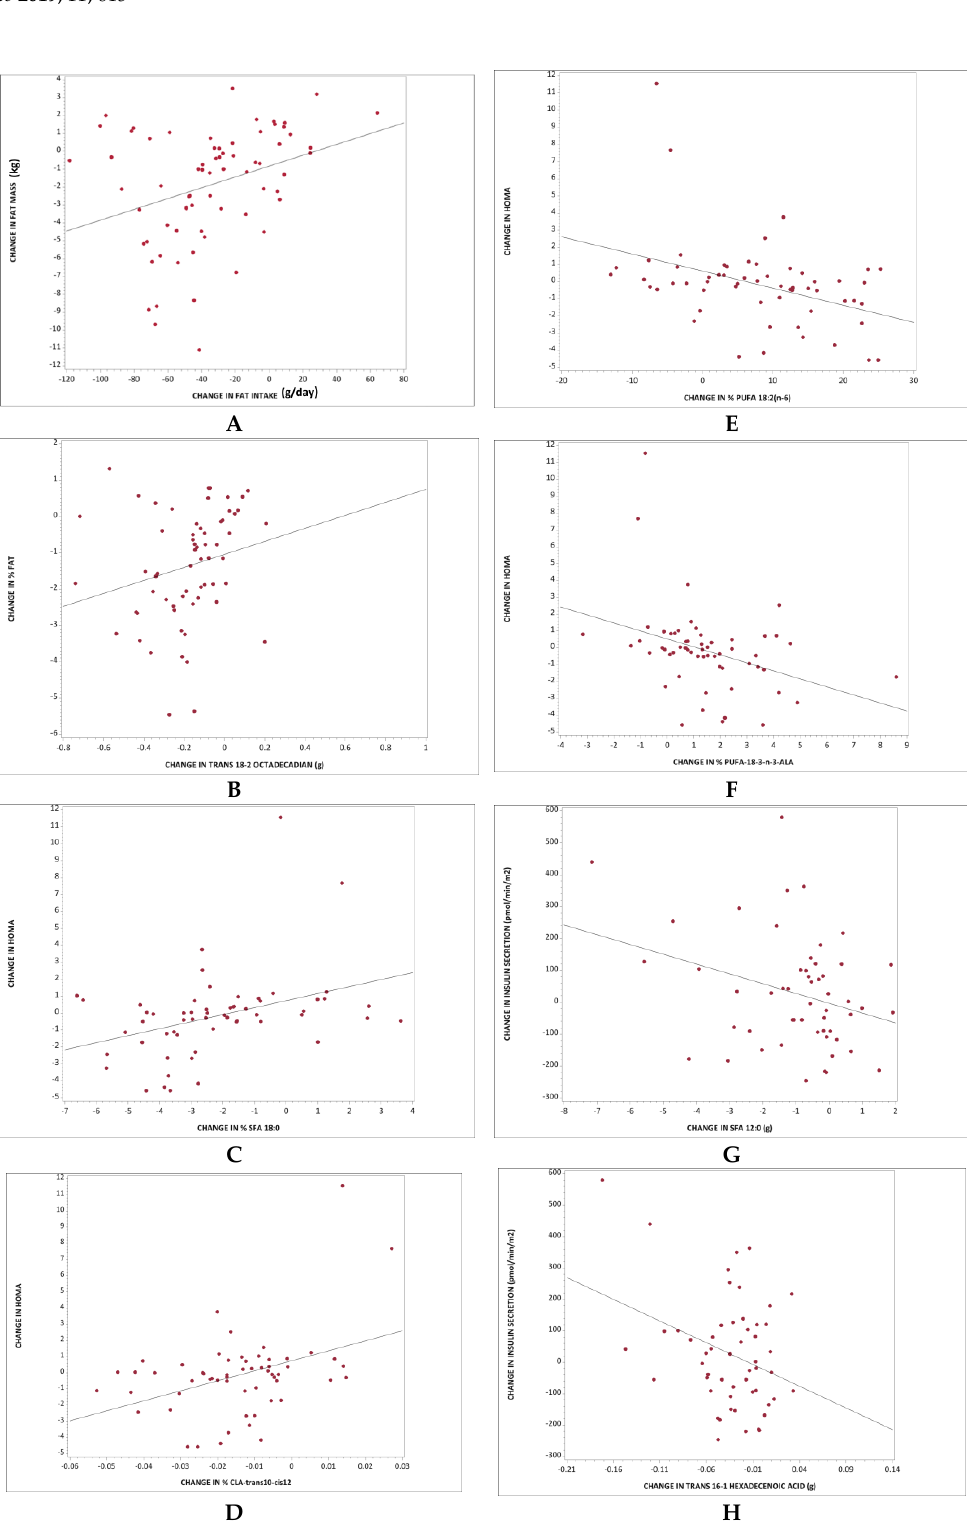
Figure 3. Regression models for changes in fatty acid intake and changes in body composition, insulin resistance, and insulin secretion. ( A ) Total fat intake and change in fat mass: r = 0.52; p < 0.001; ( B ) Intake of TRANS 18:2 and change in percentage of body fat: r = 0.35; p = 0.004; ( C ) Intake of C18:0 and changes in Homeostasis Model Assessment (HOMA-IR) index: r = 0.37, p = 0.004; ( D ) Intake of CLA-trans10-cis12 and changes in HOMA-IR: r = 0.40, p = 0.002; ( E ) Intake of C18:2 and changes in HOMA-IR: r = − 0.36, p = 0.006; ( F ) Intake of C18:3 and changes in HOMA-IR: r = − 0.40, p = 0.002; ( G ) Intake of C12:0 and changes in fasting insulin secretion: r = − 0.31, p = 0.03; ( H ) Intake of TRANS 16:1 and changes in fasting insulin secretion: r = − 0.33, p =